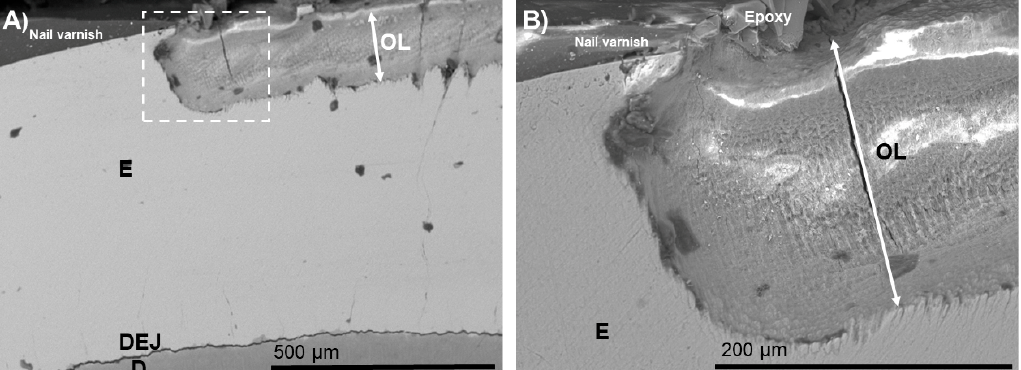
Figure 1. ( A ) SEM images of cross-sections of the bacteria-induced enamel demineralization (BIED- control) with nail varnish shown protecting the unexposed surface. ( B ) High-magnification SEM image of ( A ) showing the area under the dotted outline rectangle. E: enamel; D: dentin; DEJ: dentin– enamel junction; OL: outer lesion.